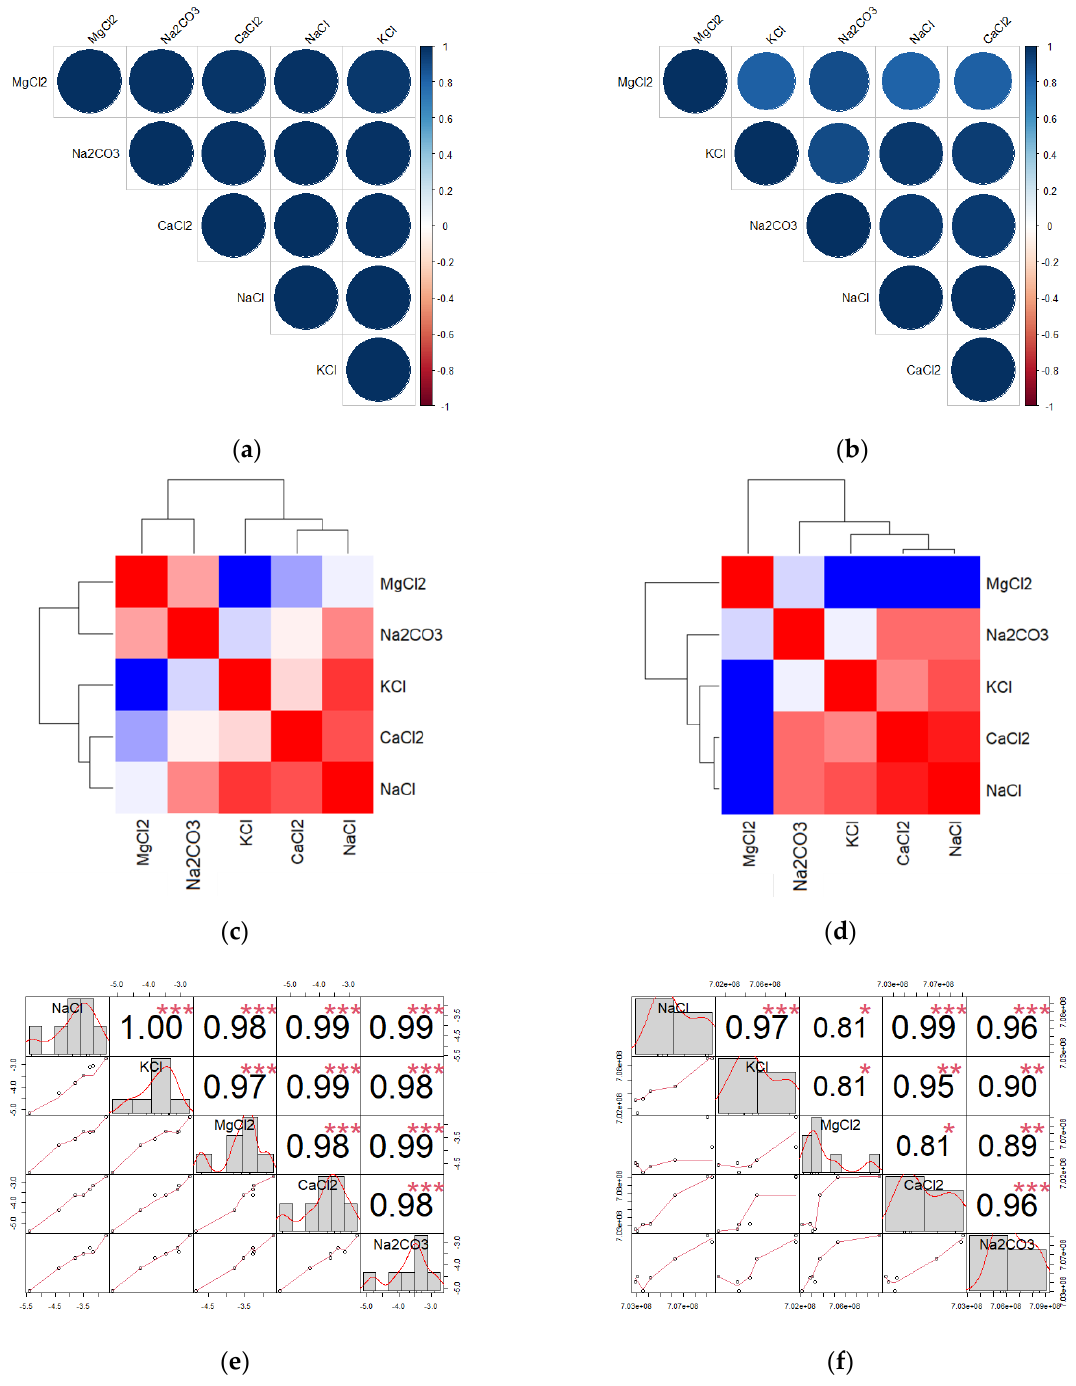
Figure 15. The correlation between all independent variables from the raw data obtained from the third resonance peak: ( a ) correlation plot (S 11 ), ( b ) correlation plot (F r ), ( c ) heatmap plot (S 11 ) (red color corresponds to the highest values), ( d ) heatmap plot (F r ) (red color corresponds to the highest values), ( e ) chart plot (S 11 ), and ( f ) chart plot (F r ). Each significance level is represented by a unique symbol, with the p-values 0.001 (***), 0.01 (**), and 0.05 (*).